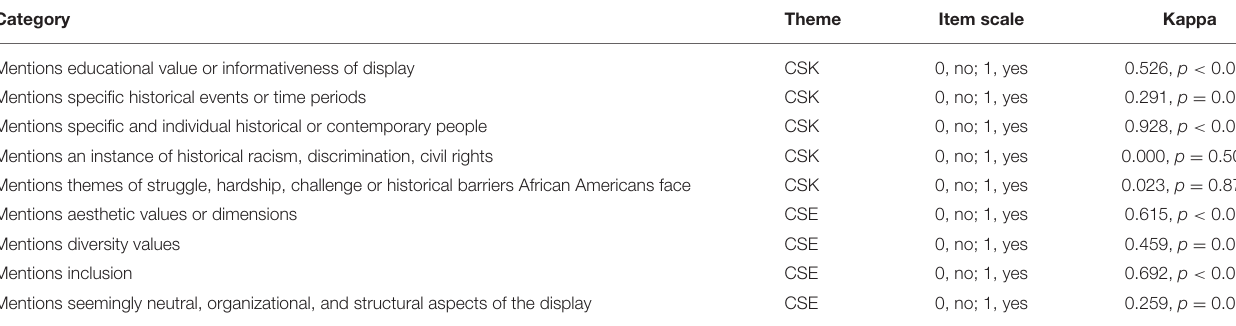
TABLE 2 | Descriptions of essay coding categories and inter-rater reliability statistics, Study